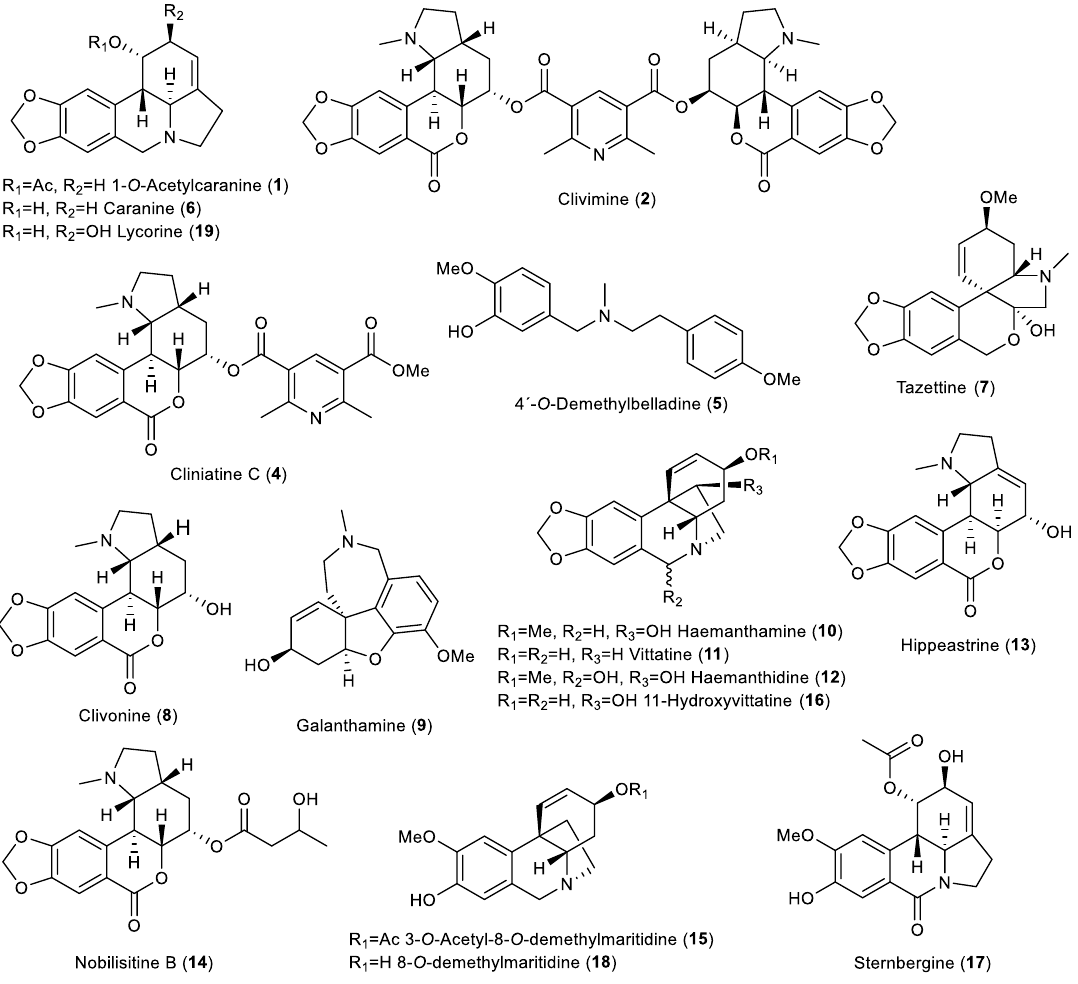
Figure 2. Isolated Amaryllidaceae alkaloids from Clivia miniate within current study. The undescribed alkaloid 3 , named as clivimine B, was obtained as a white amorphous solid. A protonated molecule [M+H] + at m / z 792.2761 was observed in the ESI-HRMS, corresponding to the molecular formula C 43 H 42 N 3 O 12+ (calcd. 792.2763), which suggested an olefinic bond in a molecule similar to clivimine (possible fragmentation of compound